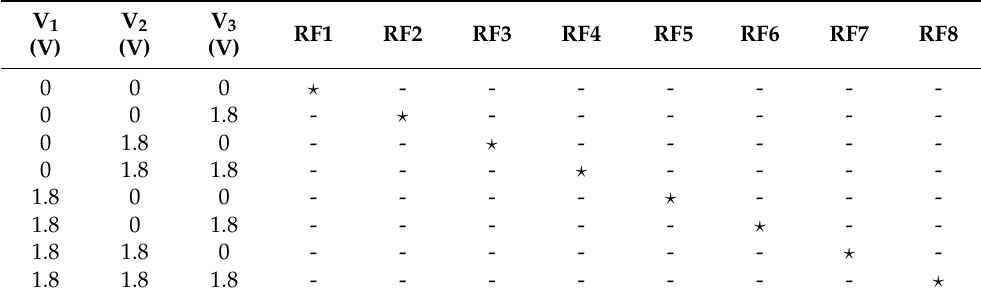
Figure 1. Schematic diagram for the concept of the TUSI probe. Table 1. The control logic of a RF Switch. Here, the symbols, (cid:63) and -, mean the connection and the isolation,